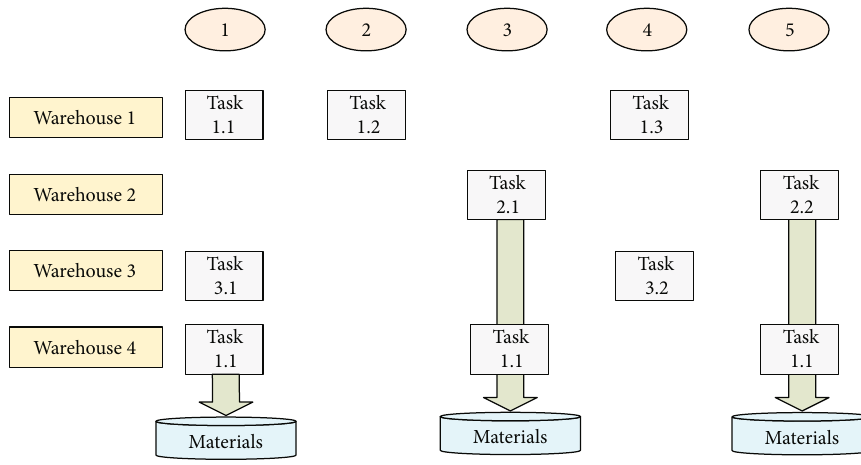
Figure 3: Demand analysis diagram of aviation material